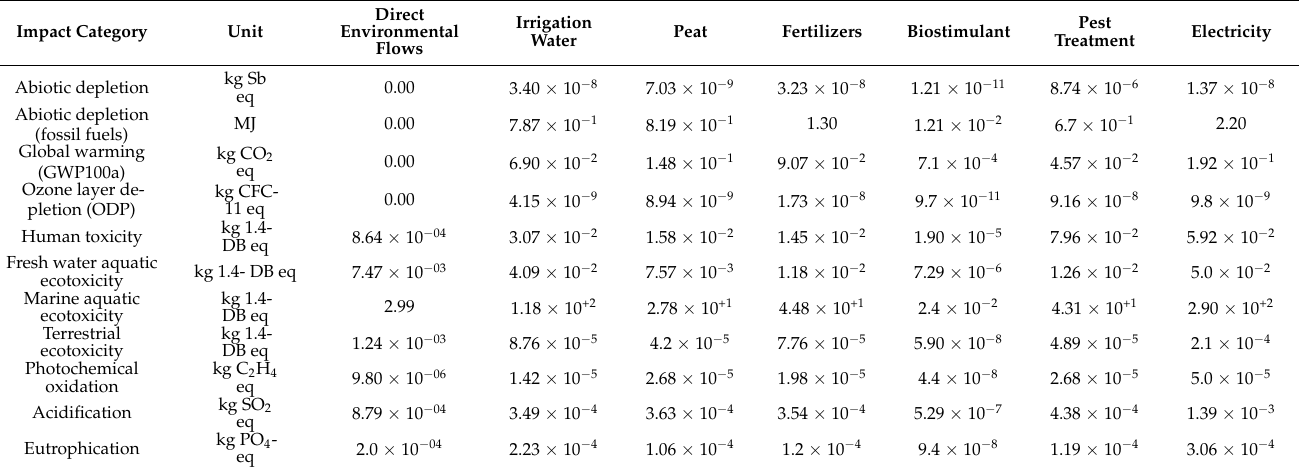
Table 7. S50 Characterization stage of the impacts of 1 kg of lemons for the specified methodol- ogy (CML-IA baseline). Absolute values. Long-term emissions (>100 years) are included, and infrastructure processes are